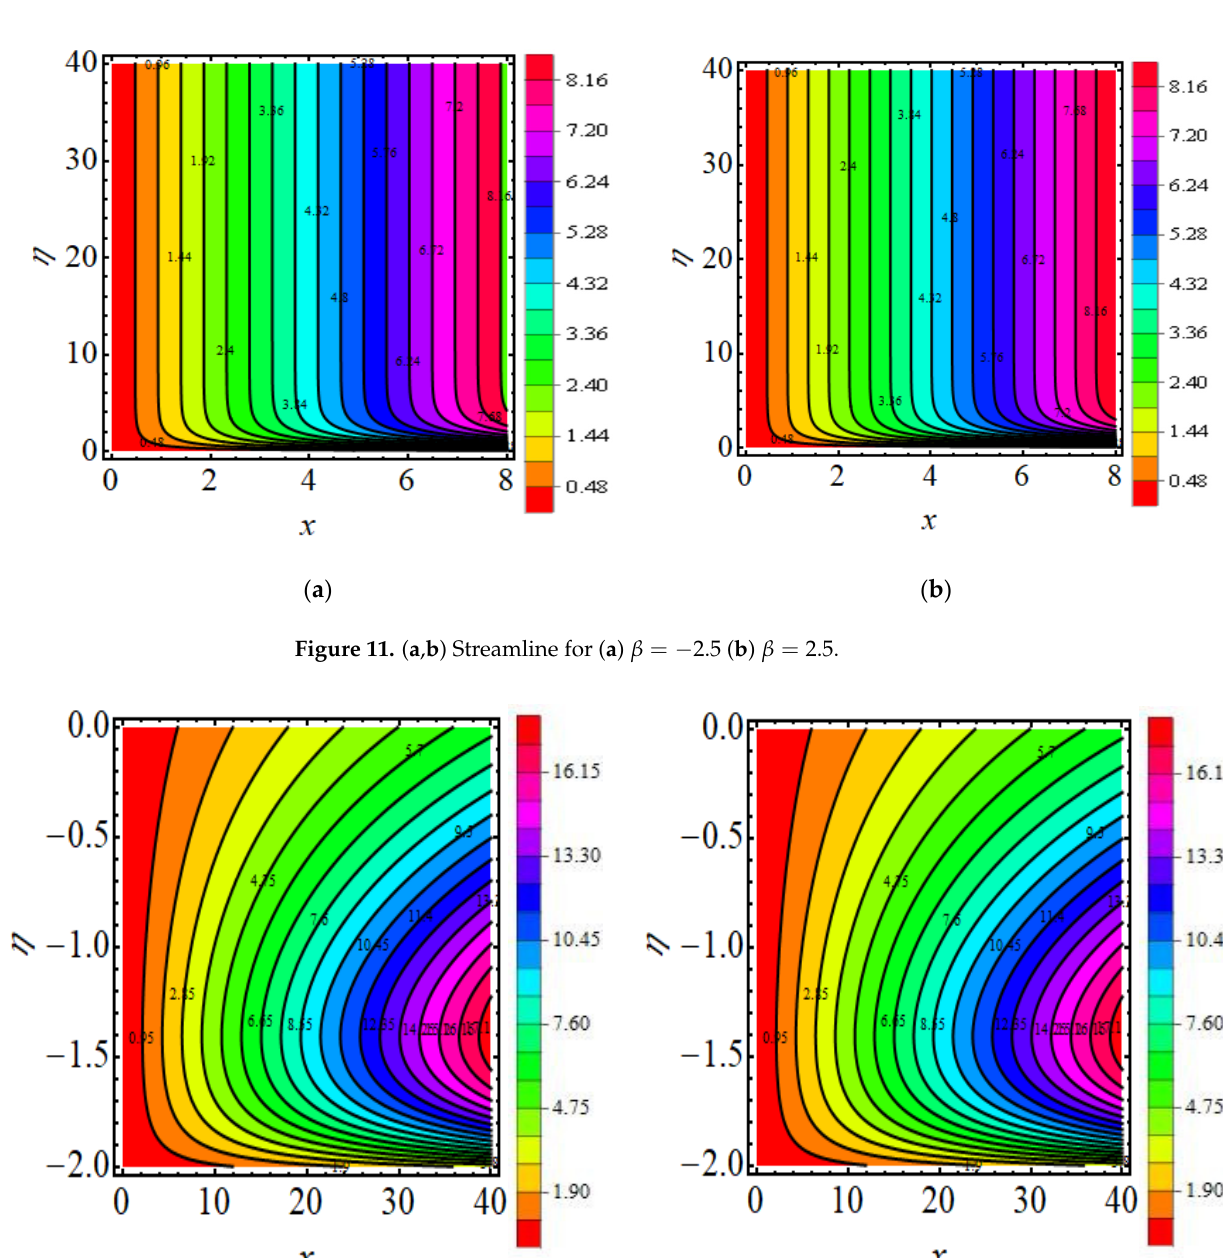
Figure 12. ( a , b ) Isotherms lines ( a ) 2.5